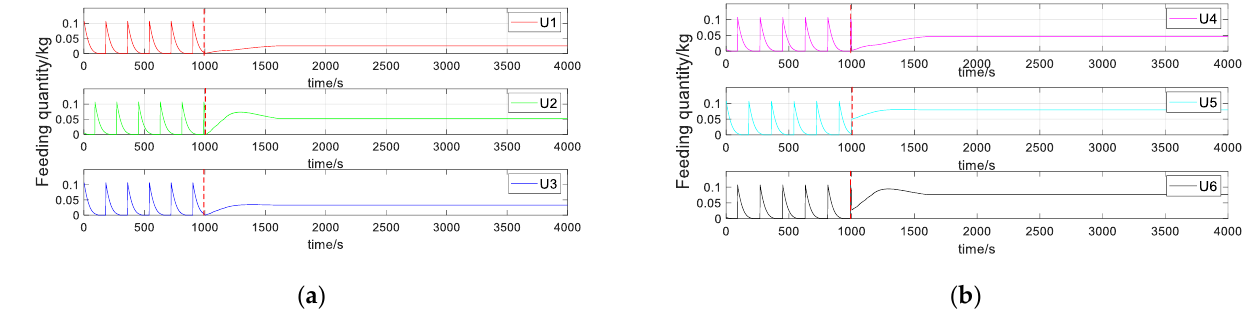
Figure 8. Distributed feeding quantity control: ( a ) subsystems 1 – 3; ( b ) subsystems 4 – 6.